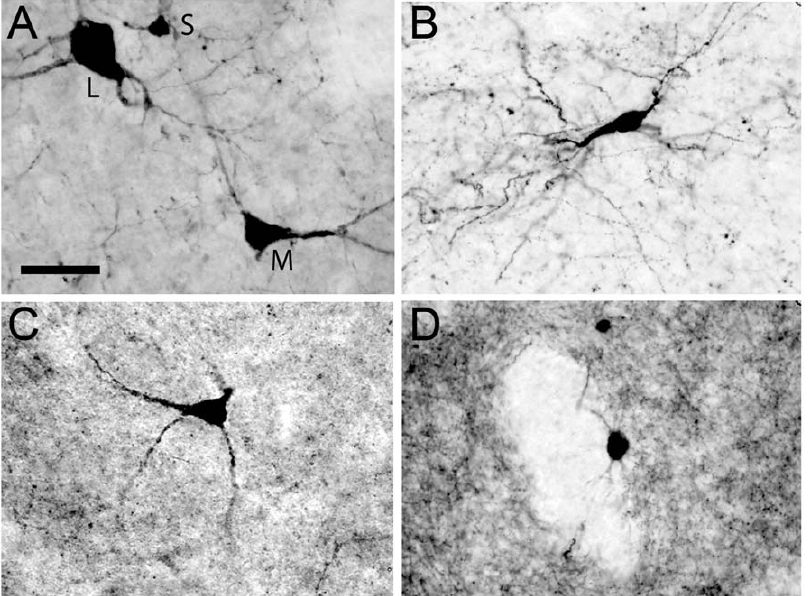
Figure 1. Photomicrographs showing the populations of interneurons included in the study. A, CR-ir (S, small, M, medium, L, large); B, PV- ir; C, CB-ir; and D, TH-ir cells. Calibration bar: 40 m m for all images.